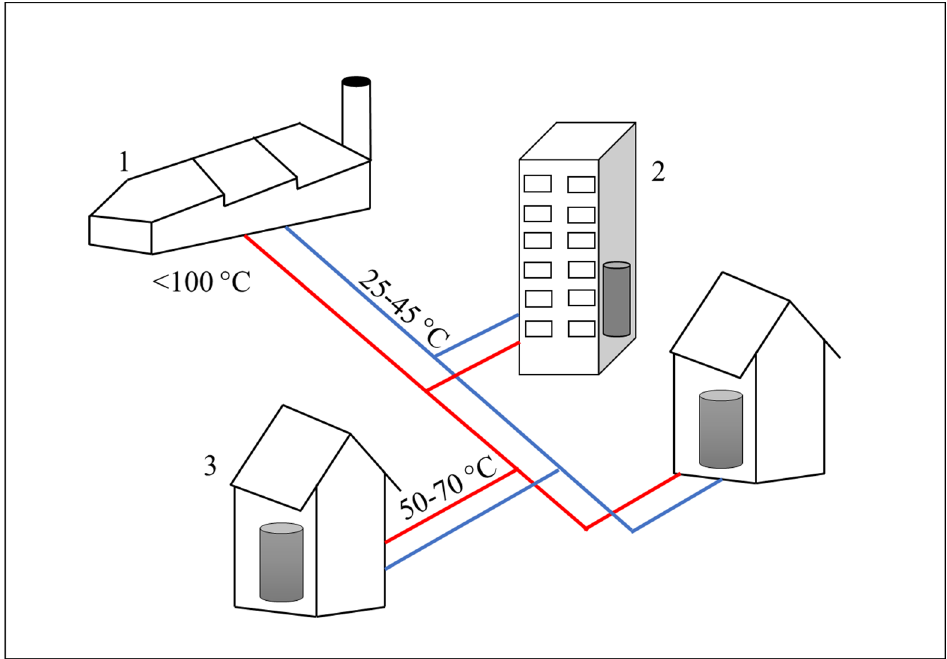
Figure 10. District heating and cooling with decentralized heating (1—generation plant, 2,3—DH users).